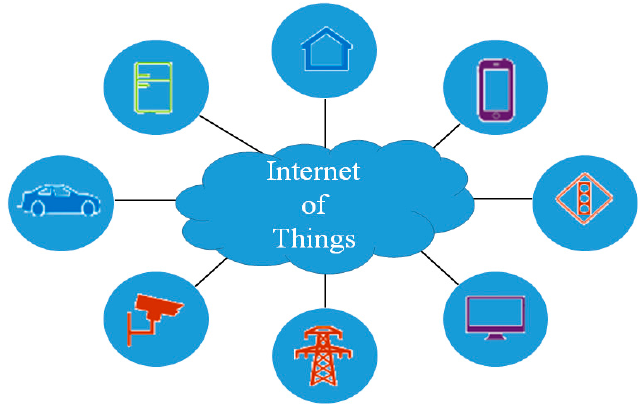
Figure 2. Concept of the Internet of Things.